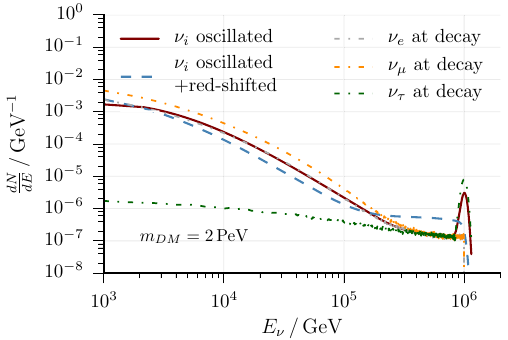
Fig. 1 Neutrino yield per decay as a function of neutrino energy (flavour-averaged): all considered decay channels (BR = 100%) are presented for an assumed dark matter mass of 2 PeV